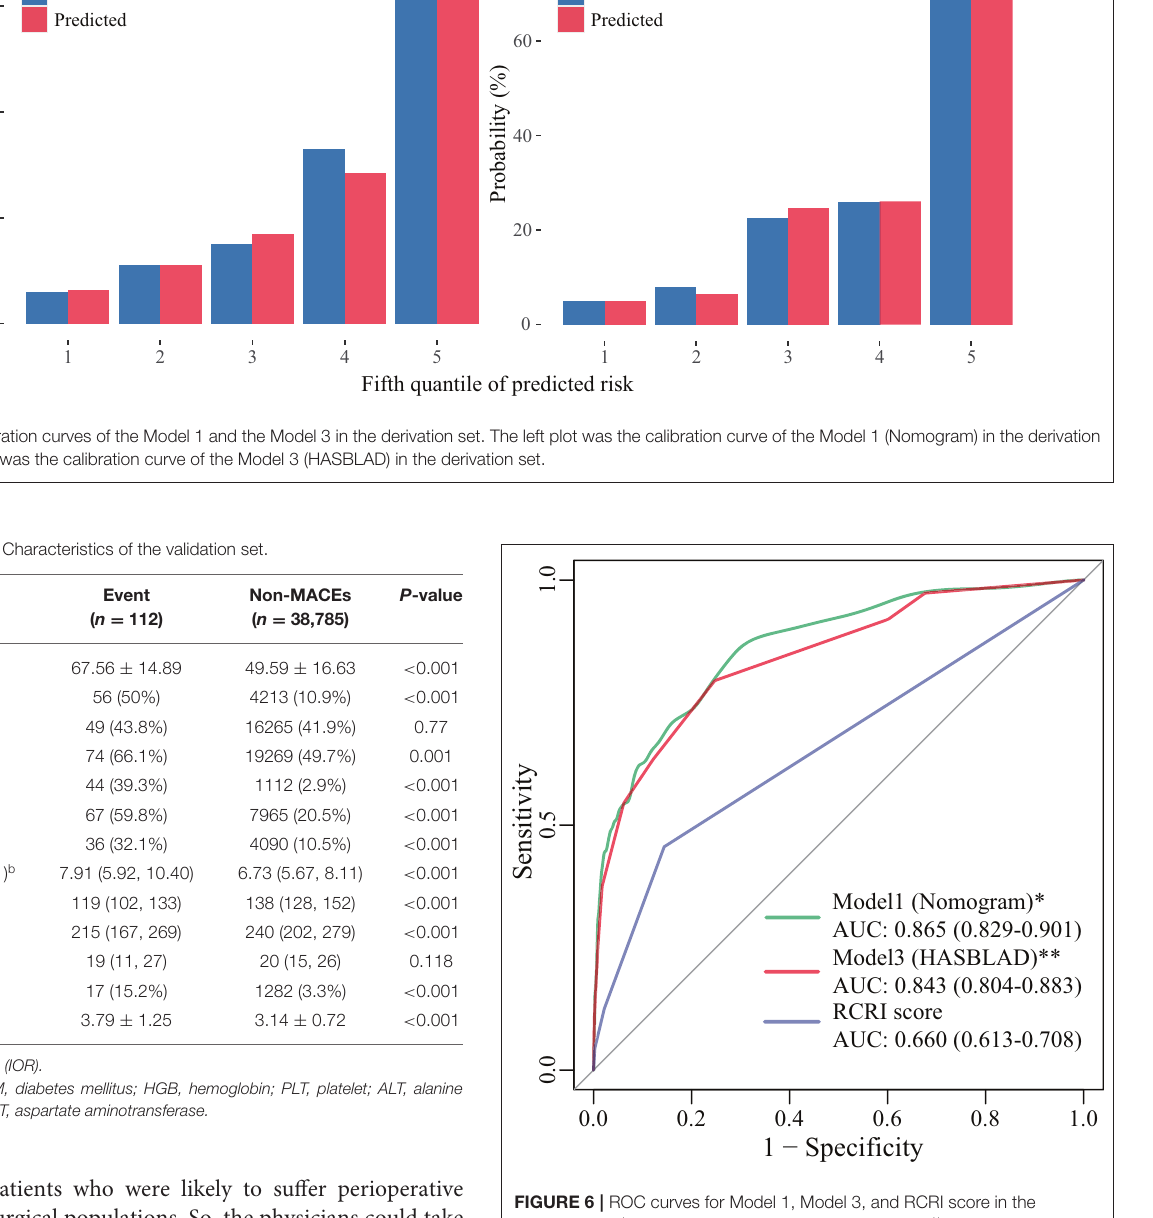
FIGURE 6 | ROC curves for Model 1, Model 3, and RCRI score in the validation set. * : P < 0.001 compared with RCRI score; ** : P < 0.001 compared with RCRI score. AUC, area under the curve; RCRI, the revised cardiac risk index; ROC, receiver operating